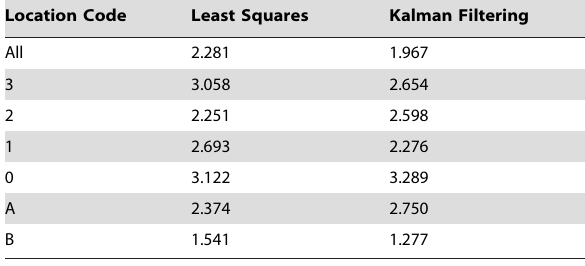
Table 6. Ratio of geometric mean longitude error to geometric mean latitude